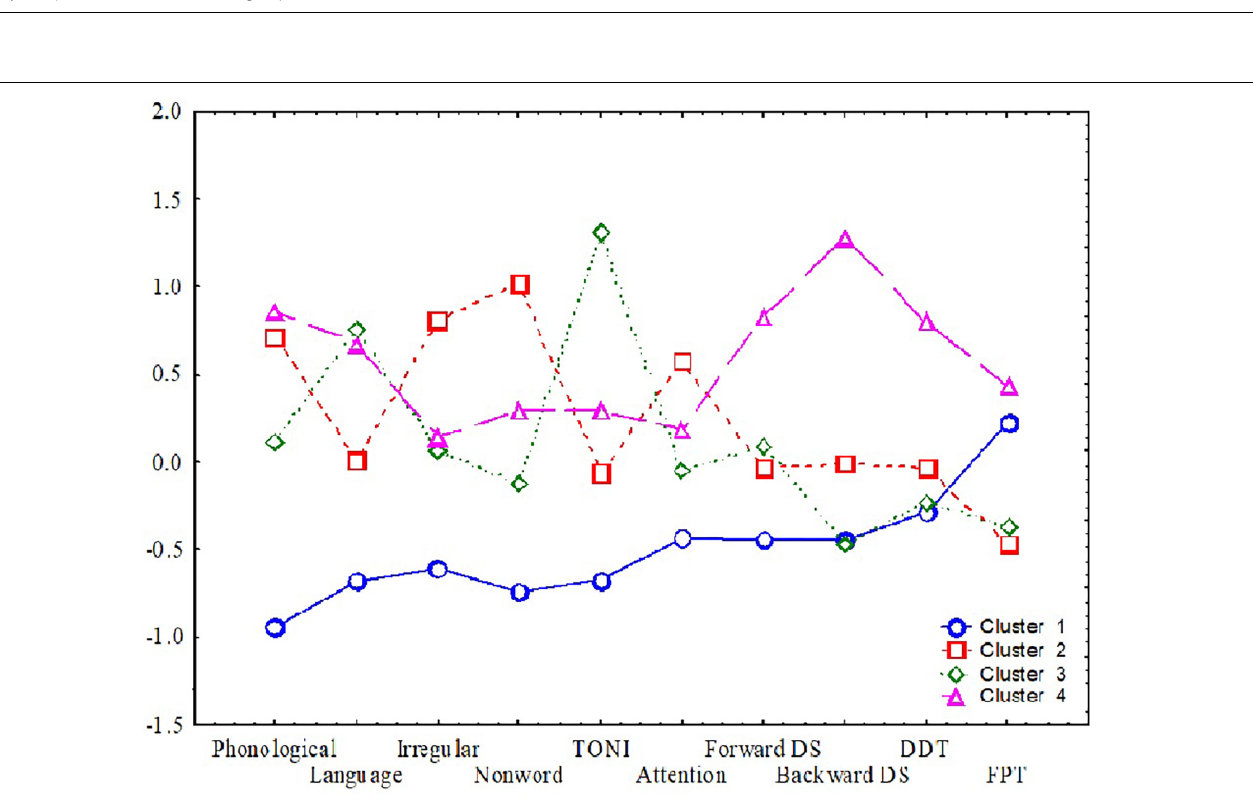
FIGURE 3 | Means for the four clusters. The y -axis shows the means (of standardized scores such that +1 is one standard deviation better than the average sample score) and the x -axis shows the 10 variables used to determine the clusters.